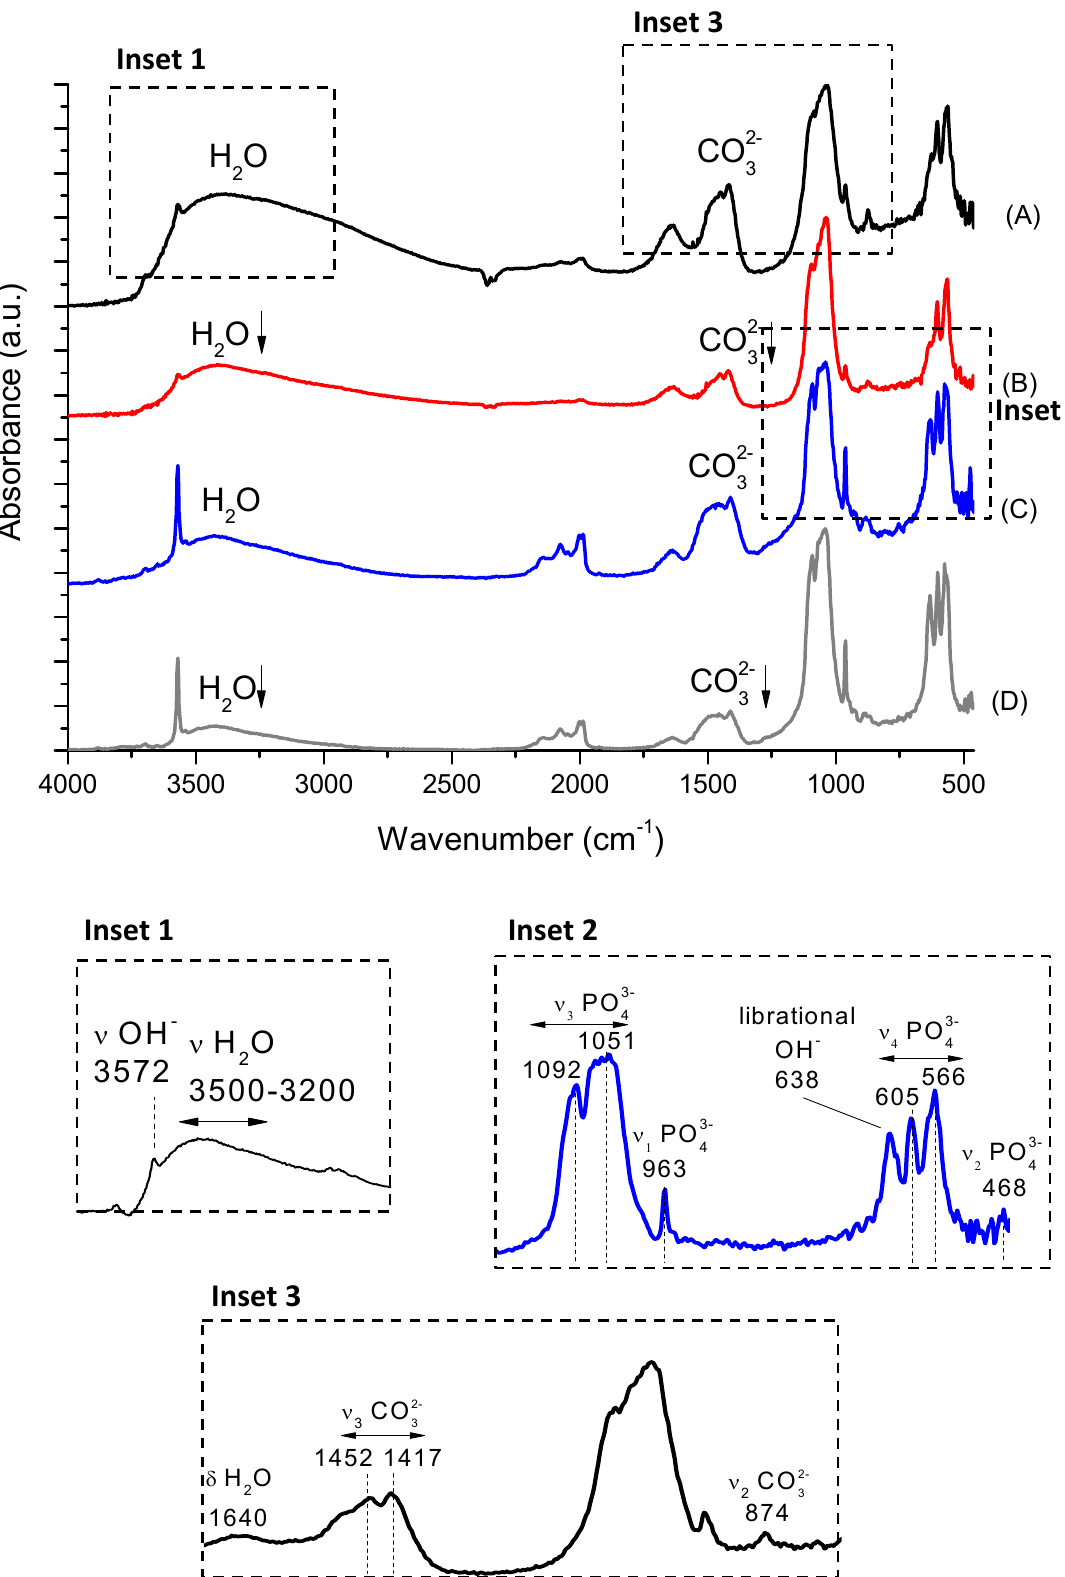
Figure 7. FTIR spectra of HA_110 ( A ); Nb-HA_110 ( B ); HA_900 ( C ) and Nb-HA_900 ( D